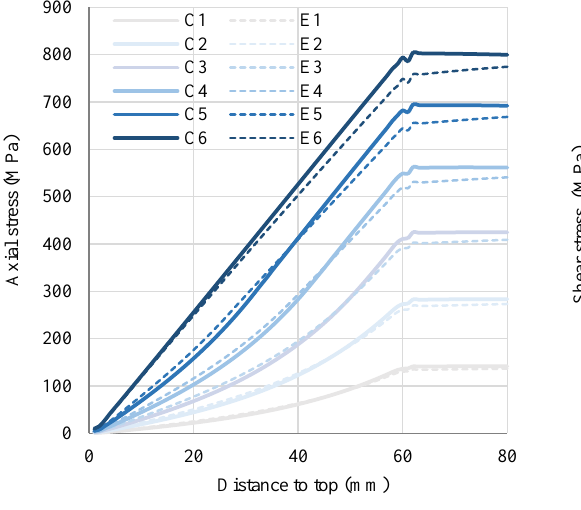
Fig. 19 Evolution of centre (C) and edge (E) axial stresses in the glass plate , vertical profile (ν = 0 .29)